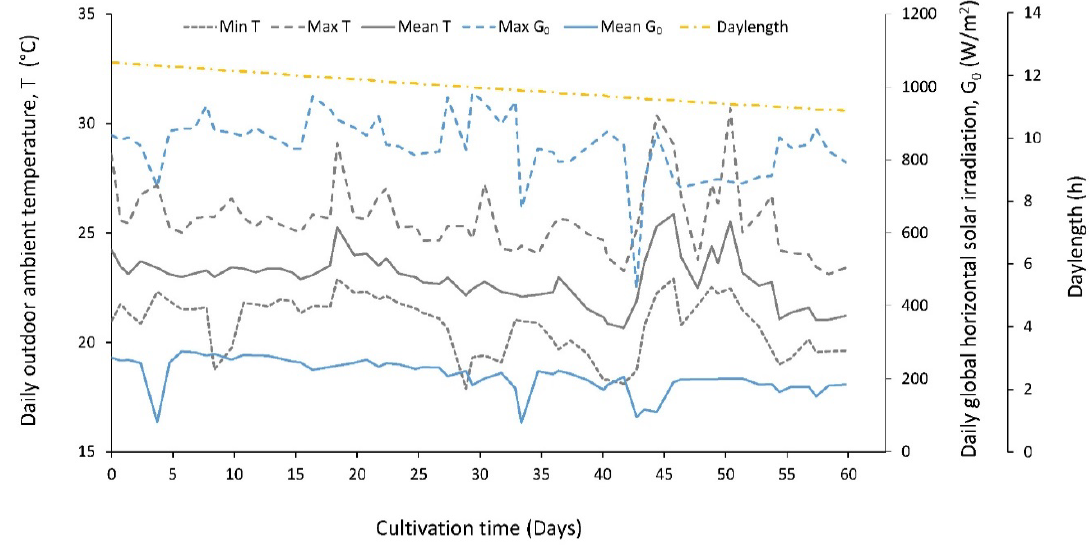
Figure A1. Minimal, maximal and mean outdoor ambient temperature (T, °C), maximal and mean global horizontal solar irradiation (G 0 , W/m 2 ), and day length in the function of the time-course of the semi continuous cultivation of A. platensis BEA 1257B in the 8000 L raceway pond inside the greenhouse (12 Sep. to 11 Oct. 2019). The environmental parameters were automatically recorded daily outside the greenhouse.